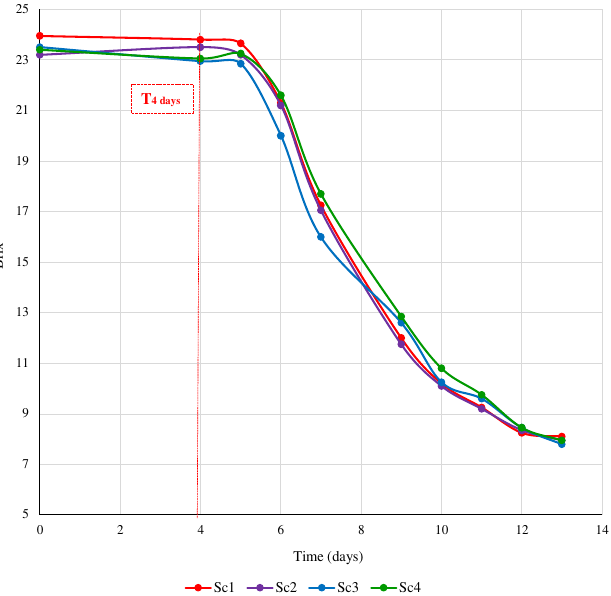
Figure 1. Alcoholic fermentation kinetics for the four vinifications carried out with the different yeasts (Sc1, Sc2, Sc3, and Sc4). °Brix given as average values (n = 2).